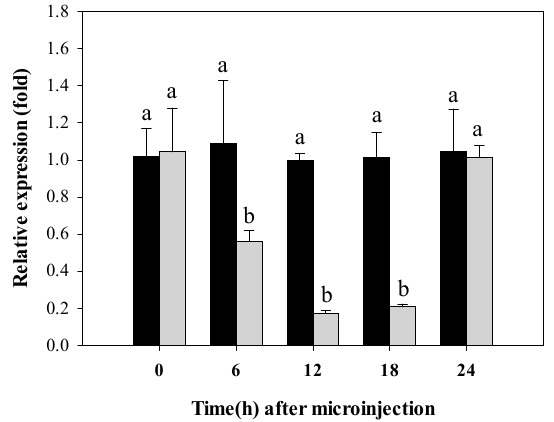
Figure 5. Relative expression levels of CYP340W1 (grey bars) at different times after CYP340W1 dsRNA was injected into third-stage larvae of ABM-R. Expression is relative to that of CYP340W1 injected dsEGFP (black bars), and CYP340W1 expression injected dsEGFP was set to 1. Values are means and standard errors. The lowercase letters above the error bars mean significant difference in expression levels according to Tukey’s test p < 0.05 ( n = 3).